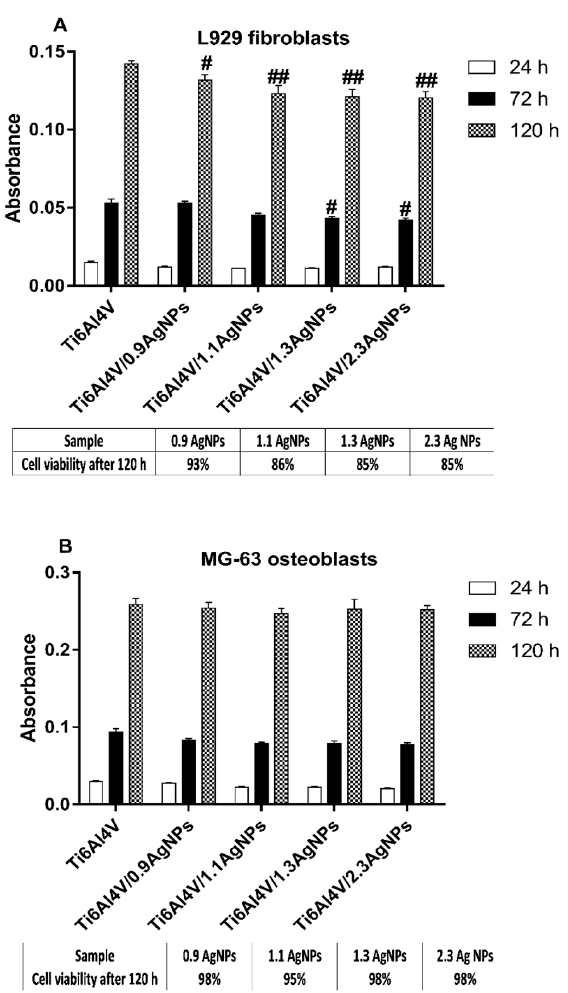
Figure 8. The L929 murine fibroblasts ( A ) and human osteoblasts MG-63 ( B ) adhesion (measured after 24 h) and proliferation (evaluated after 72 h and 120 h) on the surface of Ti6Al4V/AgNPs, detected by the MTT (3-(4,5-dimethylthiazol-2-yl)-2,5-diphenyltetrazolium bromide) assay. The absorbance values are expressed as means ± SEM of five independent experiments. Hash marks indicate significant differences at the appropriate incubation time between the cells incubated on the reference Ti6Al4V alloy foils (Ti6Al4V) compared to the specimen coatings doped by the different concentrations of Ag (# p < 0.05, ## p < 0.01). Tables below Figure 8A,B presented relative L929 cells or MG-63 cell viability (%) compared to the Ti6Al4V reference sample measured after 120 h of incubation.